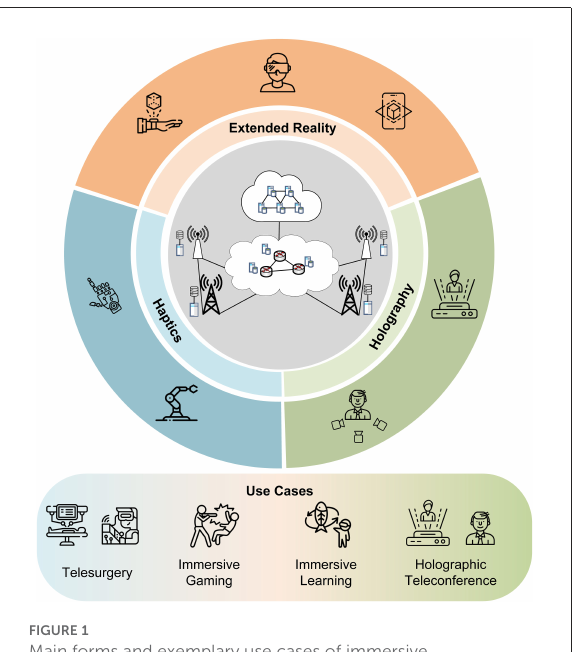
TABLE 2 Representative use cases of immersive communications.